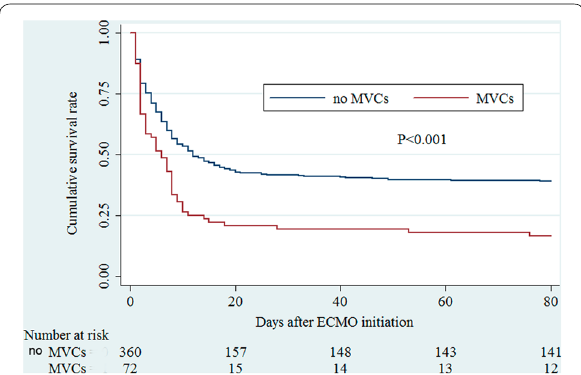
Fig. 2 Kaplan–Meier cumulative in-hospital mortality after ECMO support. Kaplan–Meier survival curves show in-hospital mortality in patients with major vascular complications (red lines) and without major vascular complications (black lines) ( p < 0.001)